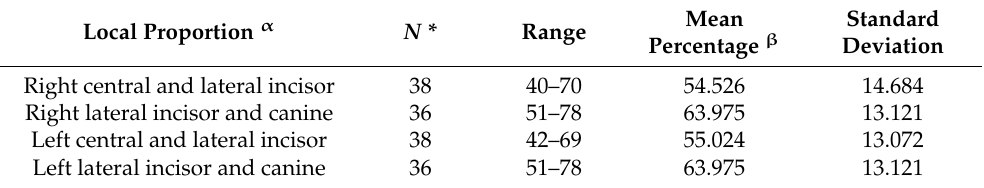
Table 5. Mean values of observed proportion from included articles ( n = 38).